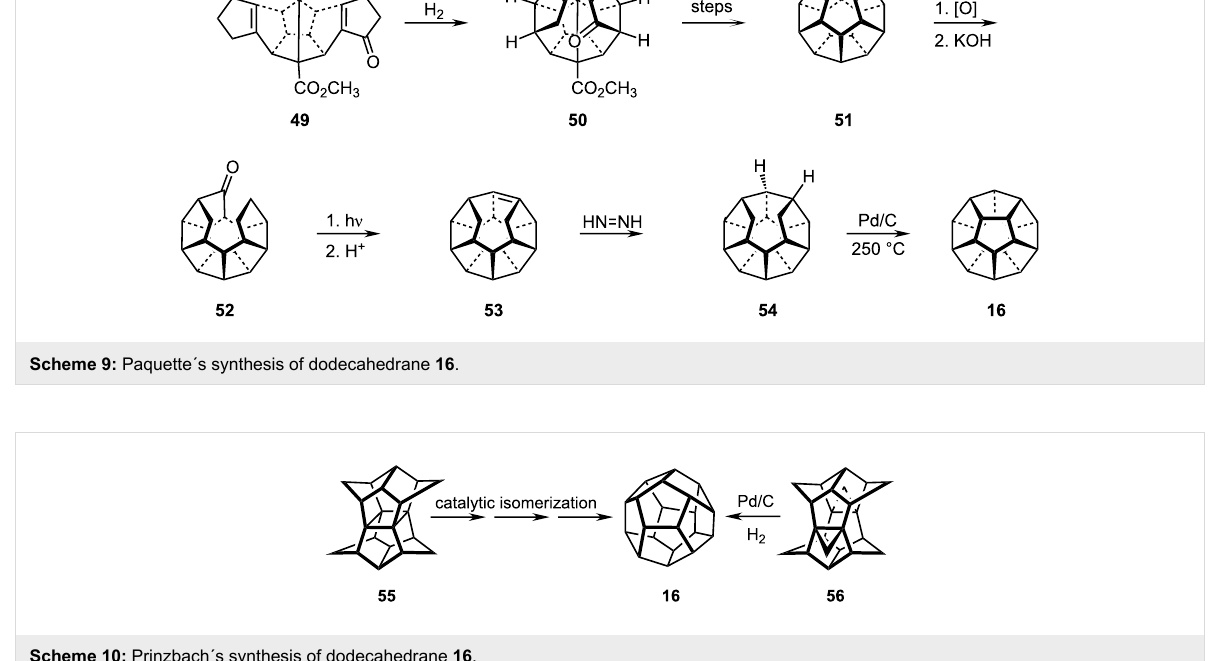
Scheme 10: Prinzbach´s synthesis of dodecahedrane 16 .